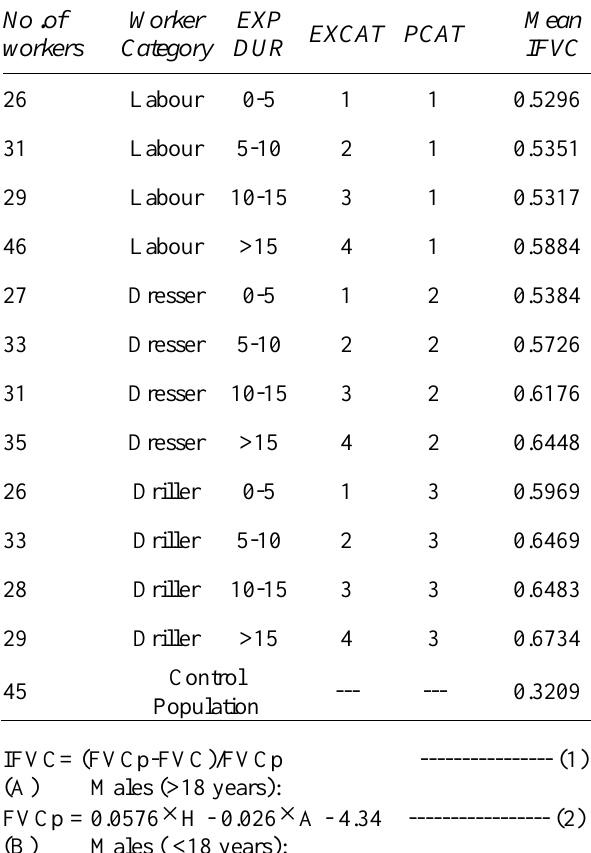
Table 4: Mean values of